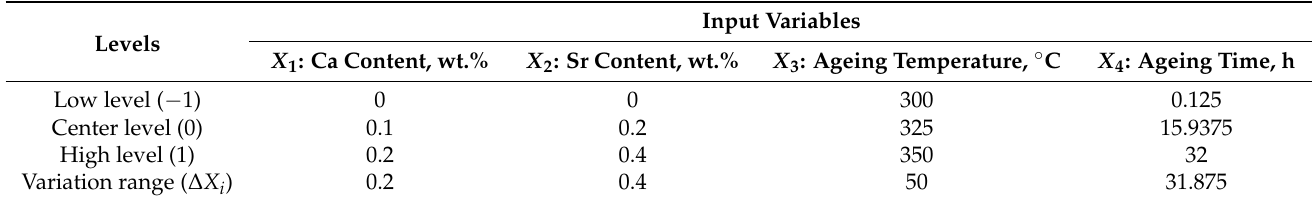
Table 3. Input variables and their